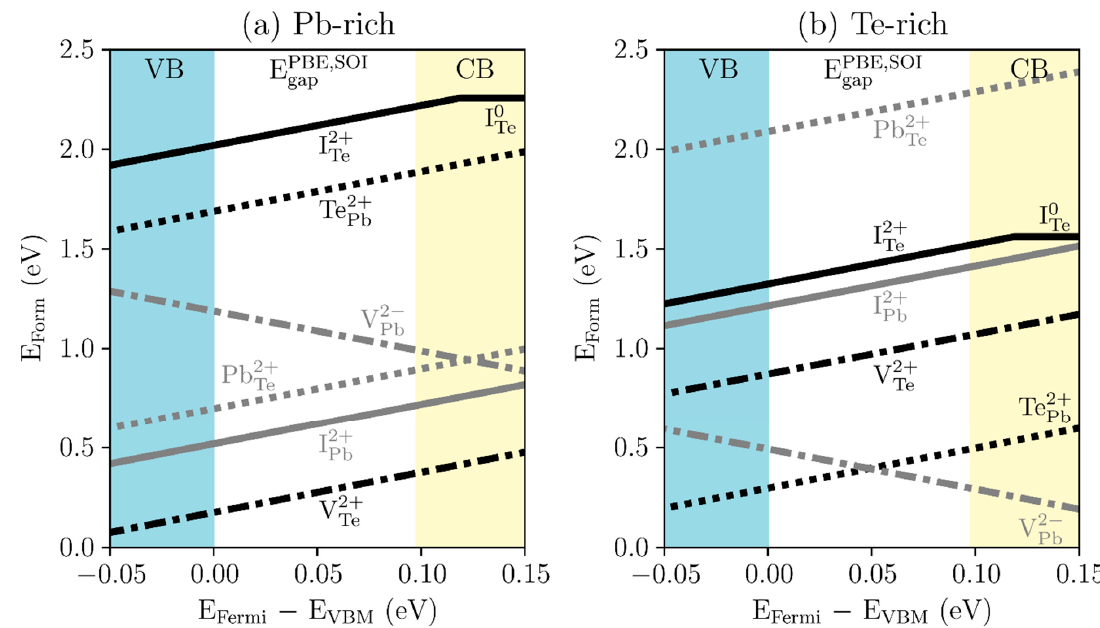
Figure 1. Charged defect-formation energies (E Form ) of high-symmetry defect configurations in PbTe under the ( a ) Pb-rich and ( b ) Te-rich conditions: Te vacancy (V Te : black dot-dashed line), Pb antisite by Te (Te Pb : black dotted line), Te interstitial (I Te : black solid line), Pb vacancy (V Pb : gray dot-dashed line), Te antisite by Pb (Pb Te : gray dotted line), and Pb interstitial (I Pb : gray solid line). The x-axis represents the difference between energies of the Fermi level (E Fermi ) and the valence band maximum (E VBM ). The yellow region indicates the conduction band (CB), the blue region the valence band (VB), and the white region the PBE energy gap with SOI (E PBE,SOI gap